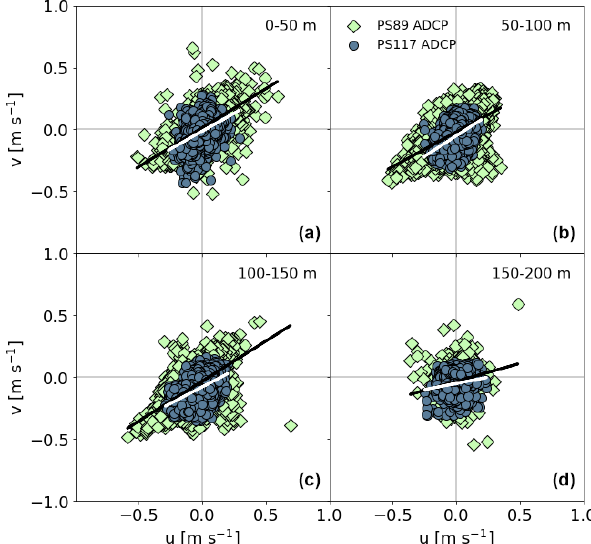
Figure F1. Correlations of the u and v components of the ADCP data for the tidal observations during PS89 (green diamonds) and PS117 (blue circles) between 0–50m (a) , 50–100m (b) , 100–150m (c) , and 150–200m (d) . All correlations are significant ( p value < 0.05) and positive, as shown with the black (PS89) and white (PS117) linear regression lines. (a) v = 0 . 63 × u + 0 . 014 (PS89); v = 0 . 58 × u − 0 . 01 (PS117). (b) v = 0 . 56 × u − 0 . 02 (PS89); v = 0 . 66 × u − 0 . 05 (PS117). (c) v = 0 . 65 × u − 0 . 03 (PS89); v = 0 . 54 × u − 0 . 08 (PS117). (d) v = 0 . 29 × u − 0 . 034 (PS89); v = 0 . 20 × u − 0 . 05 (PS117).